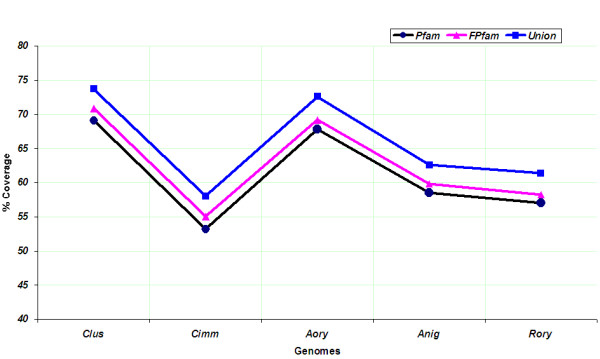
Comparison of FPfam and Pfam results for sequences in the five new fungal genomes; the test case. For each of the five fungal genomes, considered as a test case here, the Figure shows the percentage of sequences found to contain at least one domain using Pfam, FPfam and a combination. The average coverage was found to be 60.10% (Pfam), 61.53% (Fpfam) and 64.58% (combination) for the 2903 domains represented in the FPfam library. Please note that genome names are shown as a four letter code; comprising first letter from the species name and 3 letters from the genus, also shown in the Table 1